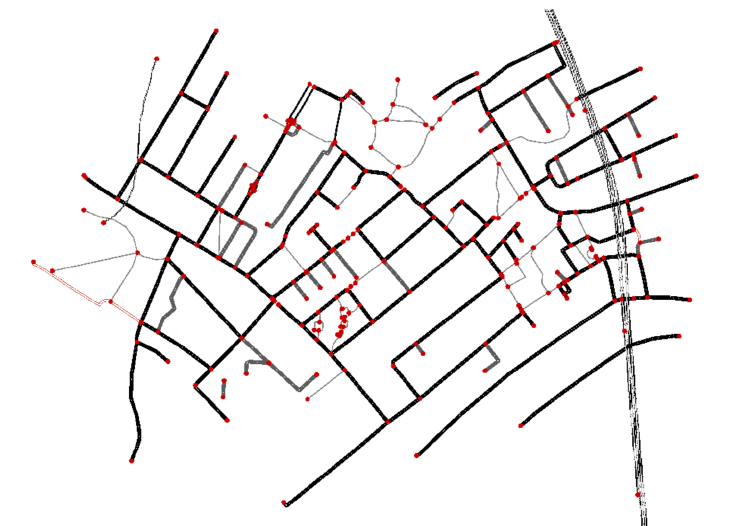
Figure 1. Representation of a road network as a graph of vertices and